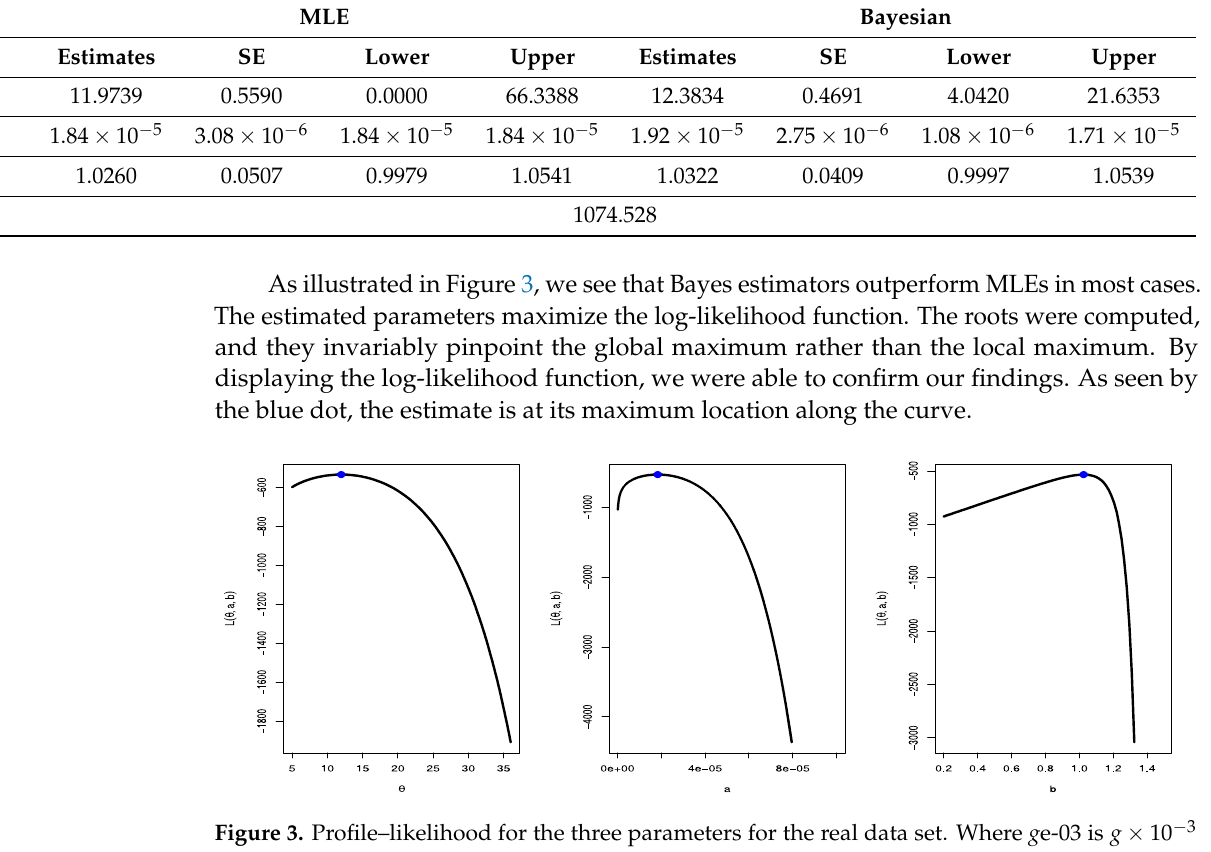
Figure 3. Profile–likelihood for the three parameters for the real data set. Where g e-03 is g × 10 − 3 Figure 3. Profile − likelihood for the three parameters for the real data set. where 𝑔 e-03 is 𝑔 × 10 (cid:2879)(cid:2871) and 𝑔 is value of parameter 𝑔 without virgule. and g is value of parameter g without